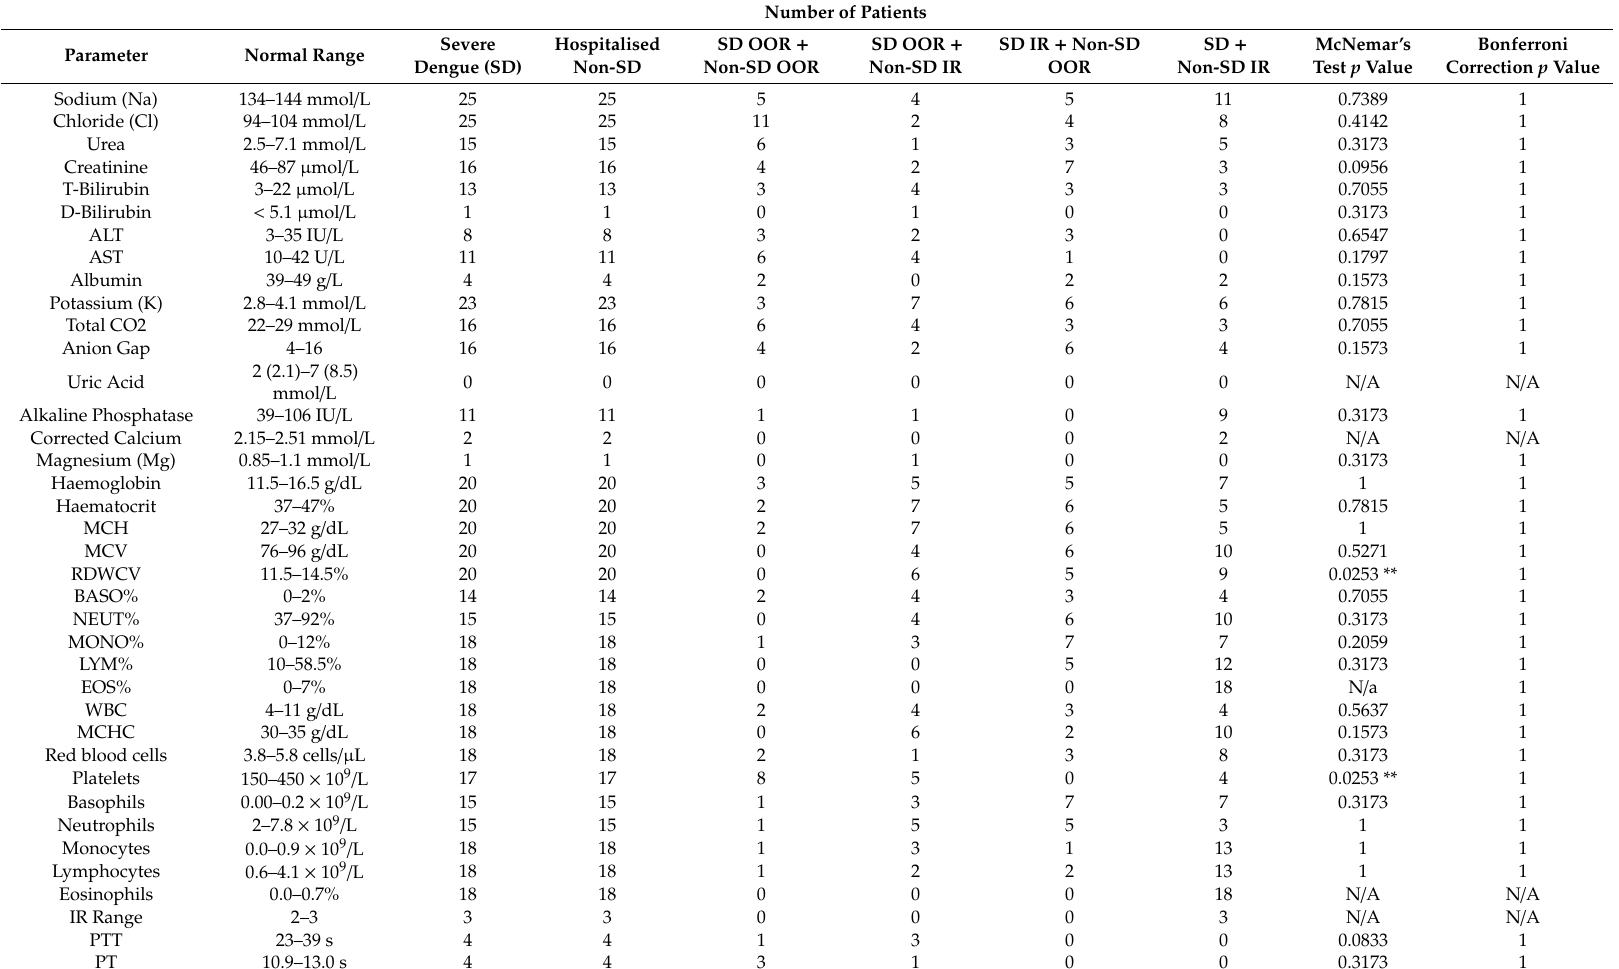
Table 4. Comparison of serum clinical chemistry parameters for SD and hospitalised DF